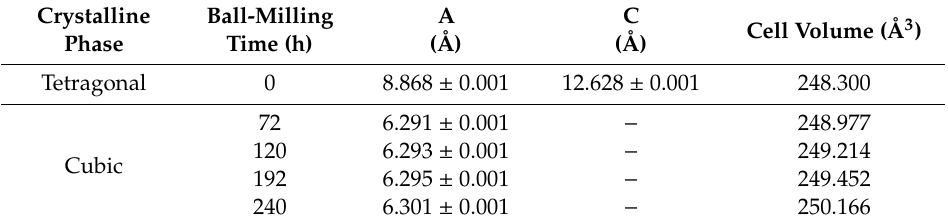
Figure 1. ( a ) X-ray diffraction (XRD) patterns of MAPbI 3 (MA = methylammonium) as a function of ball-milling time; ( b ) bottom: XRD pattern of as-prepared MAPbI 3 overlapped with the expected pattern for the tetragonal unit cell; top: XRD pattern of 72 h-milled MAPbI 3 overlapped with the expected pattern for the cubic unit cell. Table 1. Lattice parameters and cell volume for MAPbI 3 at different ball-milling times.